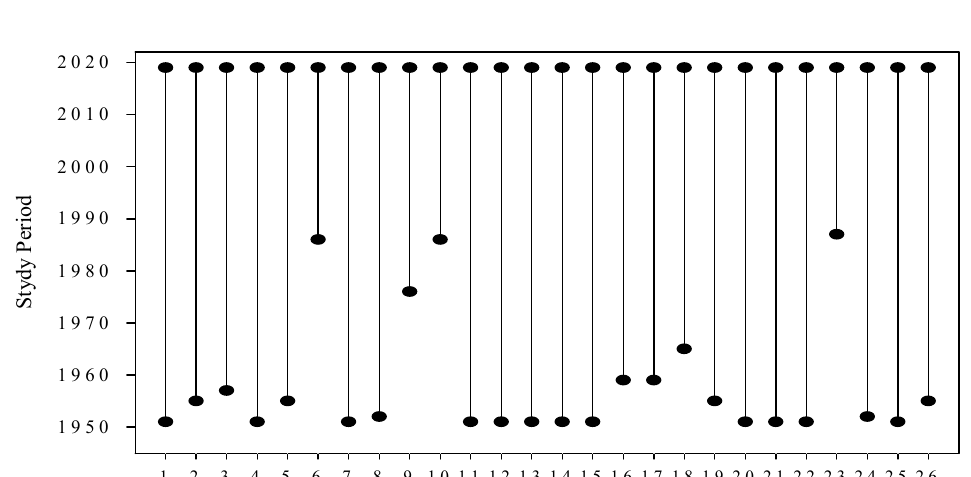
Figure 2. Study period of the precipitation and air temperature data at each station.